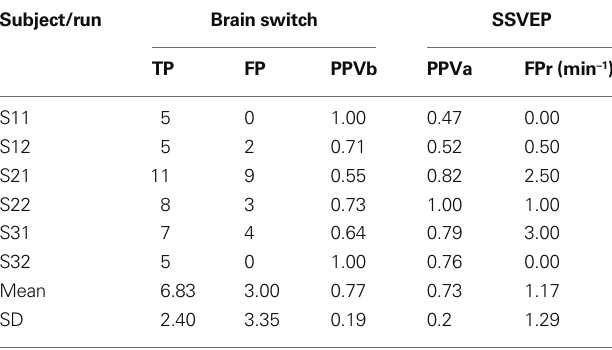
The six runs refl ect two runs each from three subjects. We show the rates of TPs, FPs and PPVb of the ERD BCI (switch) and PPVa and rate of errors/minute during resting periods (FPr) of the SSVEP